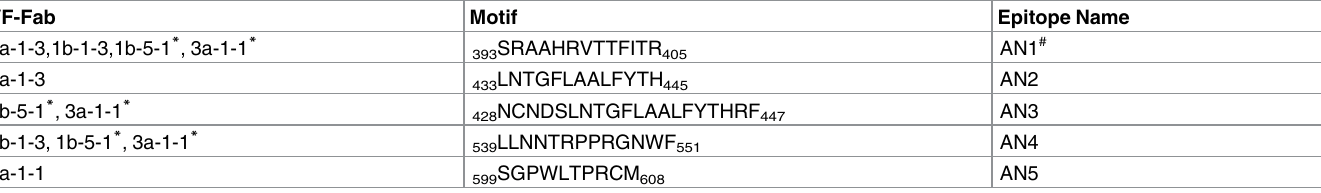
Table 4. Putative Epitopes targeted by